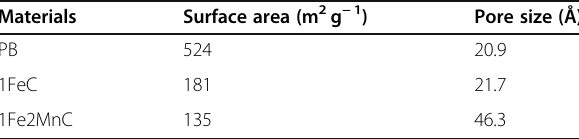
Table 3 Analysis data of surface area and pore